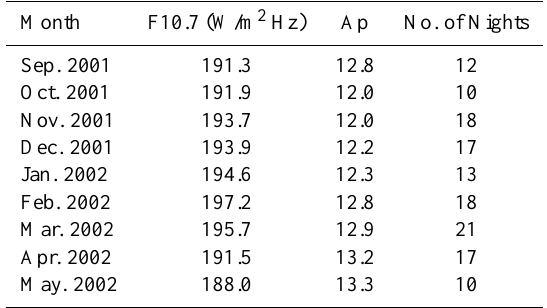
Table 1. Data summary.